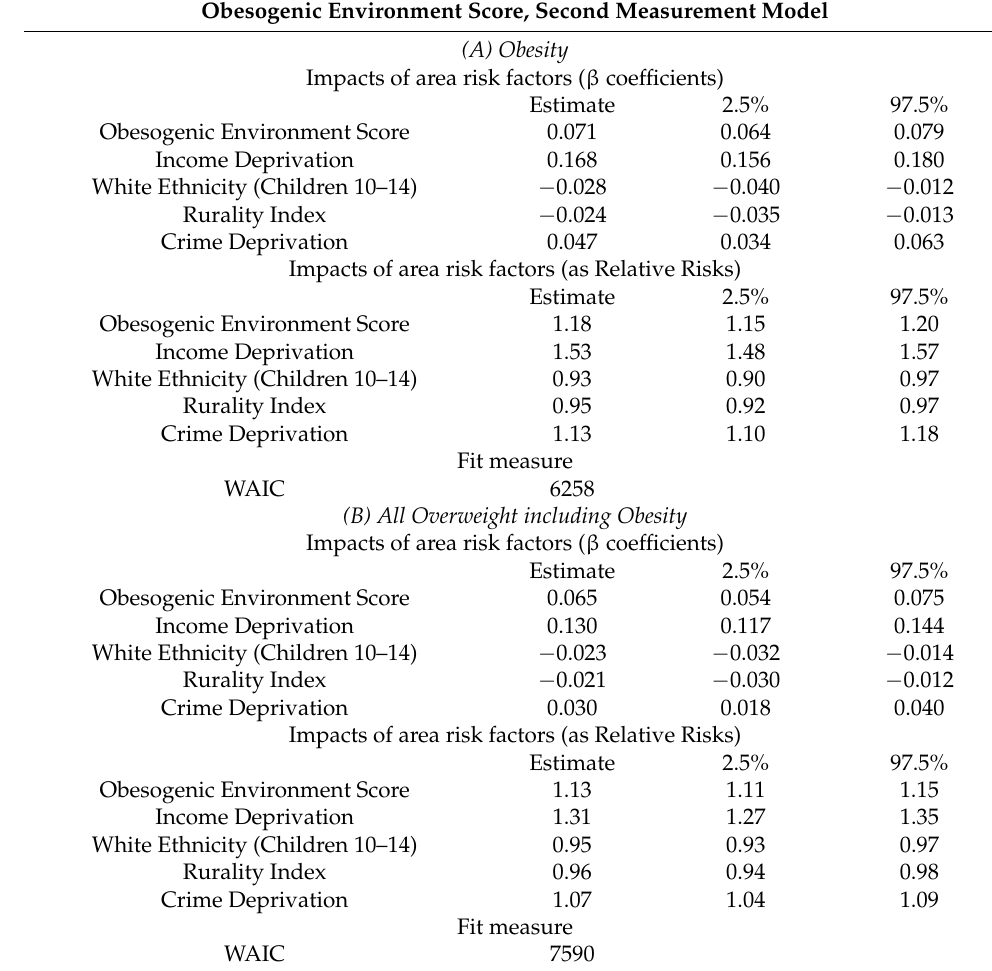
Table 4. Obesity and Overweight Regressions. Obesogenicity Second Measurement